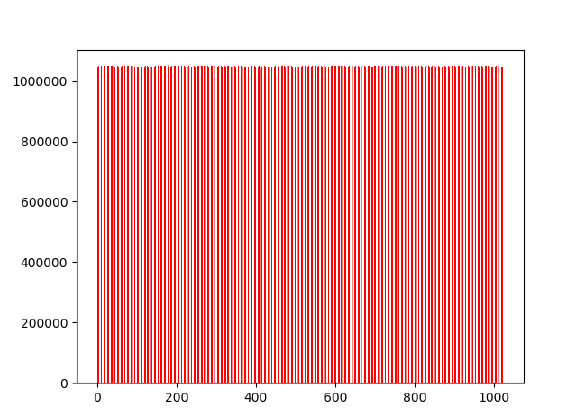
Figure 4: Histogram plotting how many times each of the 2 10 possible two successive input of the function h were reached after 2 30 Grain v1 initialization using random key and iv